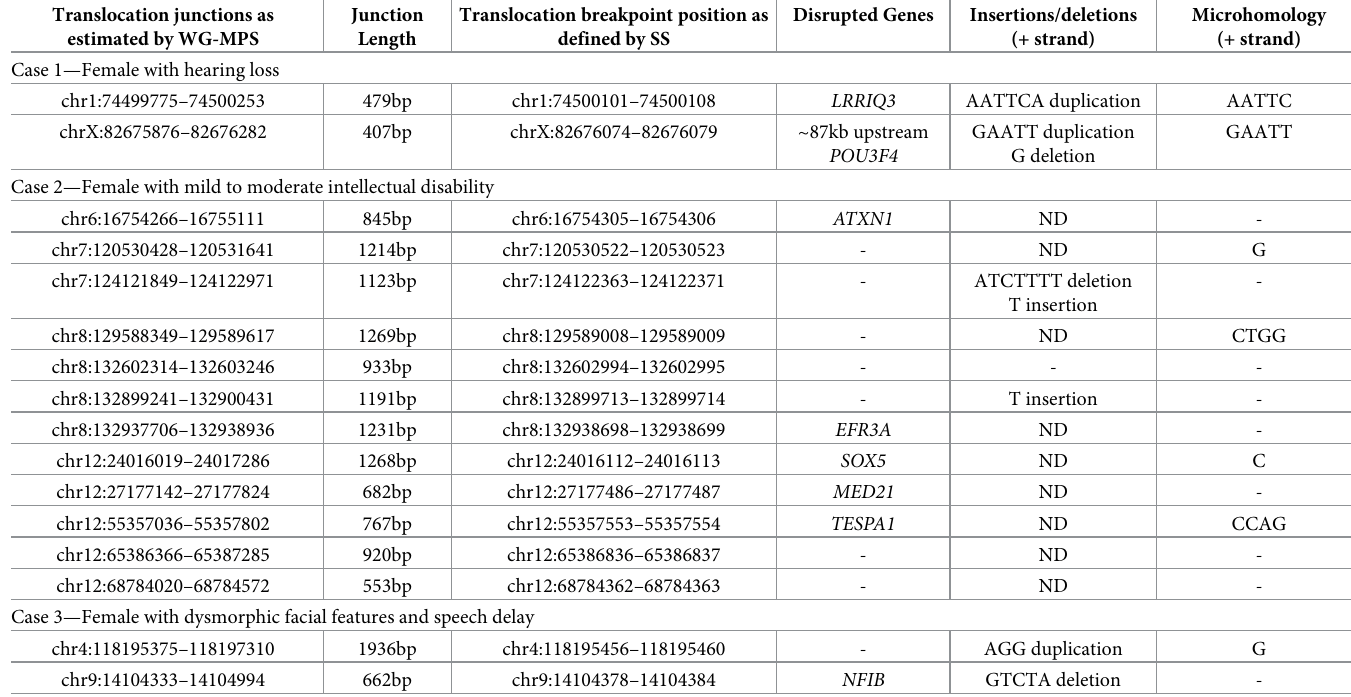
Table 1. Translocation breakpoints as identified by Whole-Genome Mate-Pair Sequencing and validated by Sanger sequencing (hg19). Translocation junctions as estimated by